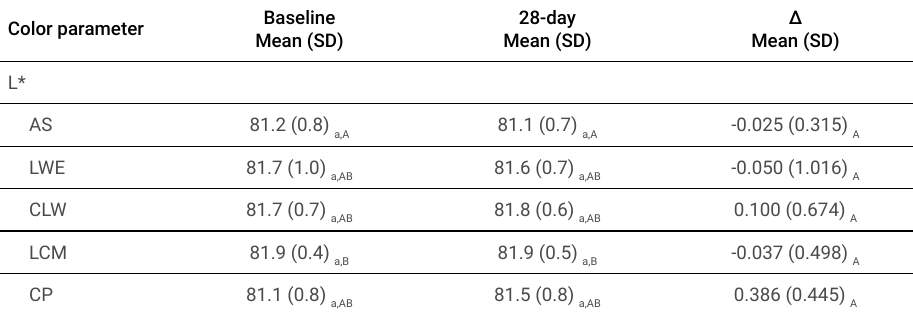
Table 2. Color parameters L*, a* and b* of the nanofilled composite Filtek Z350XT before and after application protocol in whitening and conventional mouth rinses